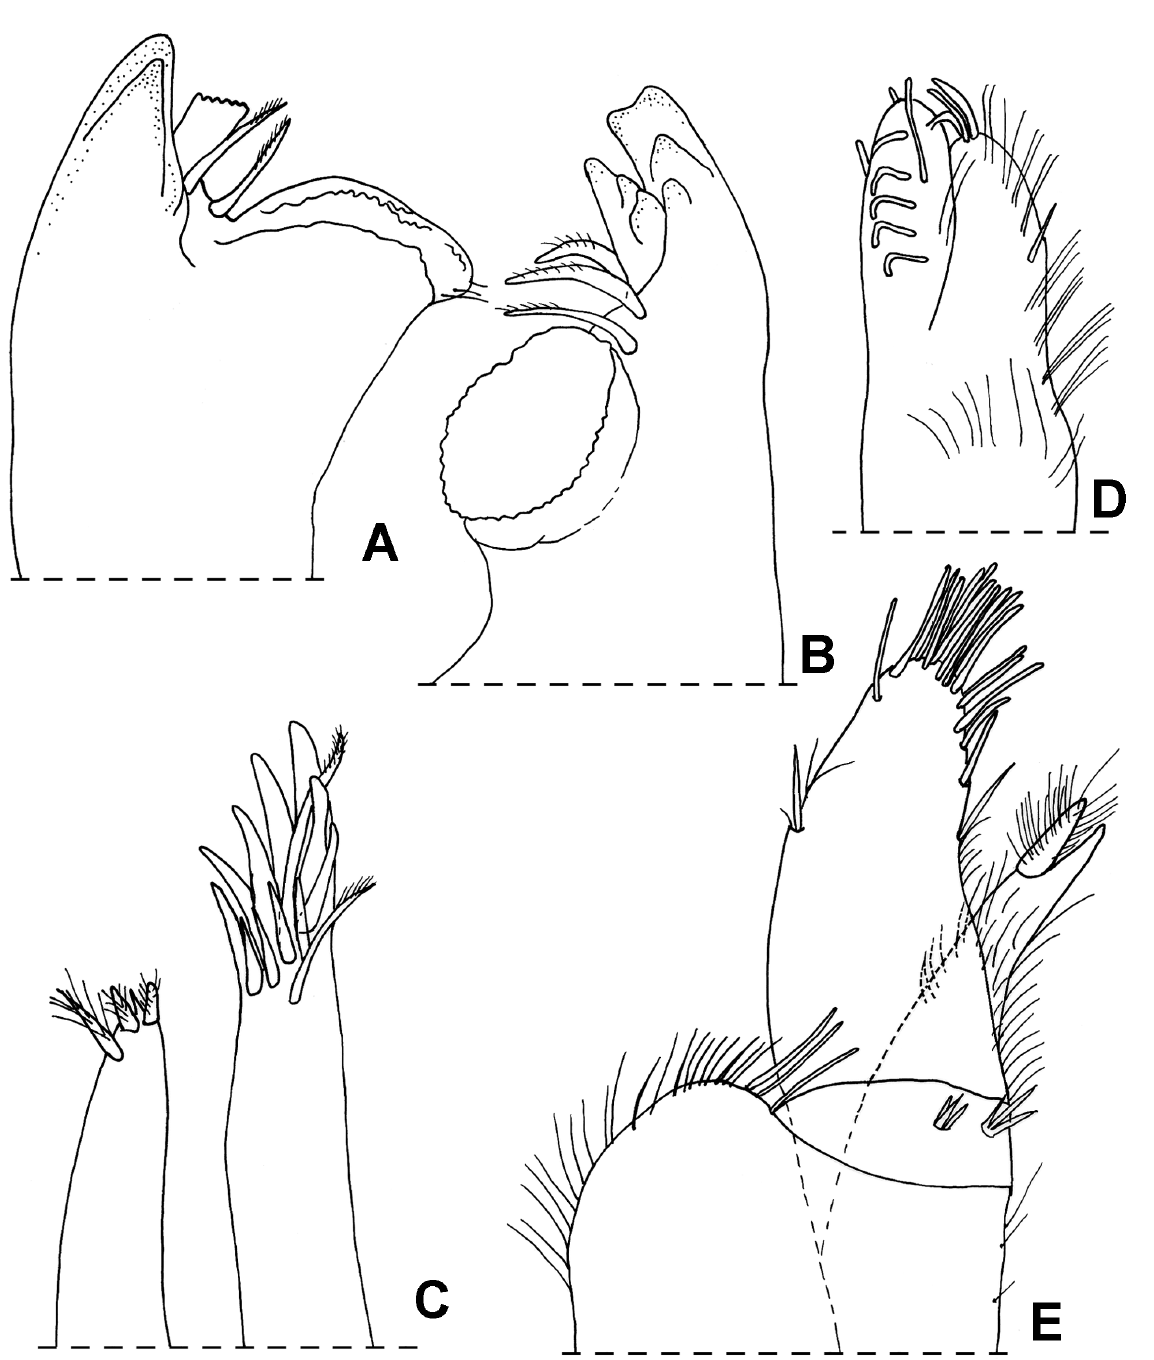
Fig. 11. Metatrichoniscoides salirensis Reboleira & Taiti sp. nov. from Gruta de Salir, Caldas da Rainha, paratype, ♂. A . Right mandible. B . Left mandible. C . Maxillula. D . Maxilla. E .